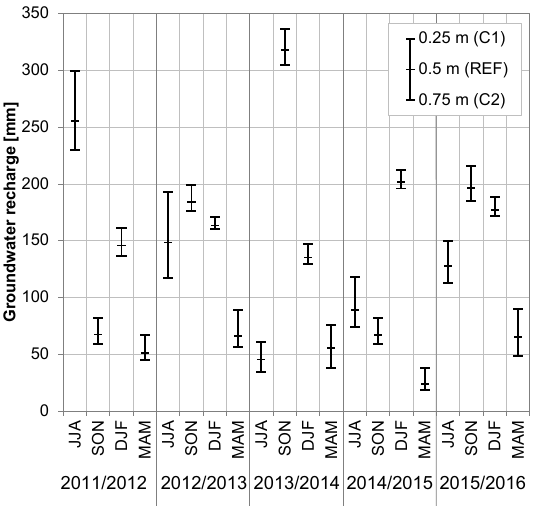
Figure 13. Simulated groundwater recharge per season (JJA: sum- mer; SON: autumn; DJF: winter; MAM: spring) from June 2011 until May 2016, for the reference model (extinction depth 0.5m), model scenario C1 (extinction depth 0.25m: less evaporation), and model scenario C2 (extinction depth 0.75m: more evaporation).